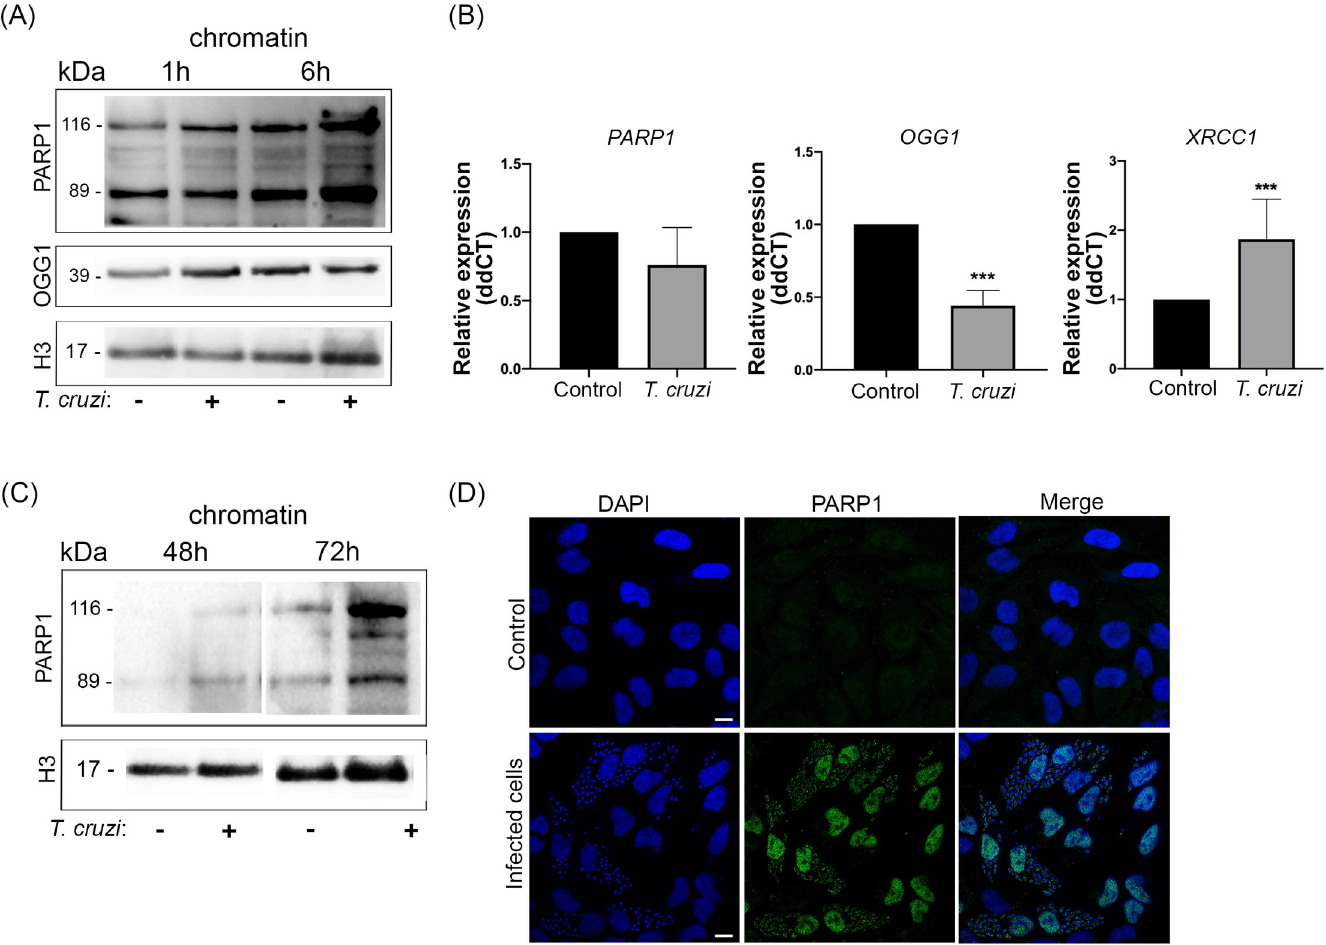
Fig 3. mRNA expression and recruitment of DNA repair enzymes from HeLa cells are regulated by Trypanosoma cruzi infection. (A) Isolated chromatin from infected cells (+) or not (-), 1 h, and 6 h post-infection were immunoblotted with anti-PARP and anti-OGG1. Anti-histone 3 (H3) was used as a loading control. (B) Relative expression (ddCT) from gene s PARP1 , OGG1 and XRRC1 from infected HeLa cells compared to control 6 h post-infection. ACTB gene was used as the endogenous control. ��� p < 0.001. (C) Isolated chromatin from infected cells (+) or not, 48 h and 72 h post-infection were immunoblotted with anti-PARP1 and loading control (H3). (D) Immunofluorescence of infected cells after 72 h of infection stained with anti-PARP1 (green) and DAPI probe (blue). Scale bar: 10 μ m.